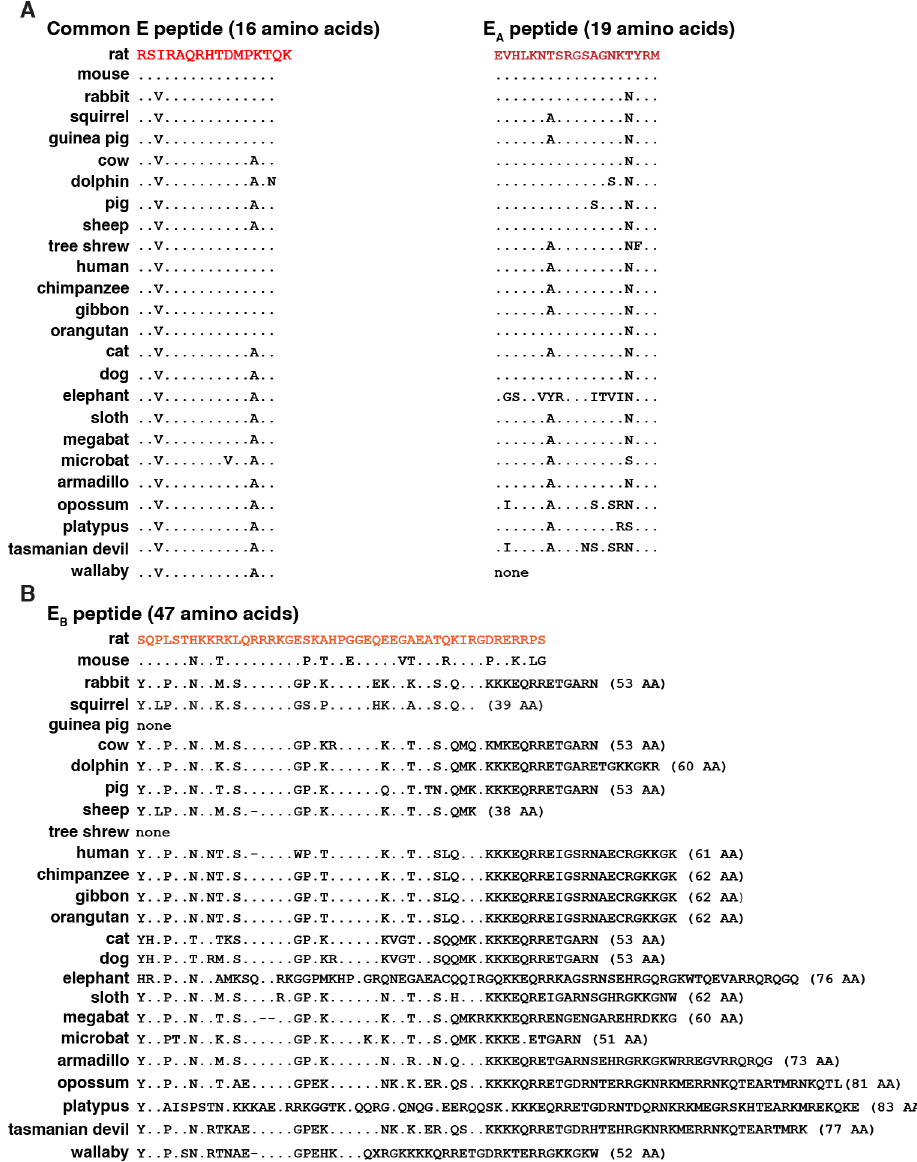
Fig 4. Alignments of mammalian IGF1 precursor peptides. A . Amino acid sequencesof COOH-terminal common E and E A peptides. B . Amino acid sequencesof COOH-terminalE B peptides. For A and B, identities are indicatedby dots and a dash depicts no residue.The number of amino acids in each E B segment is listed in parenthesis. The color of rat IGF1 amino acids corresponds with the map in Fig 1C.